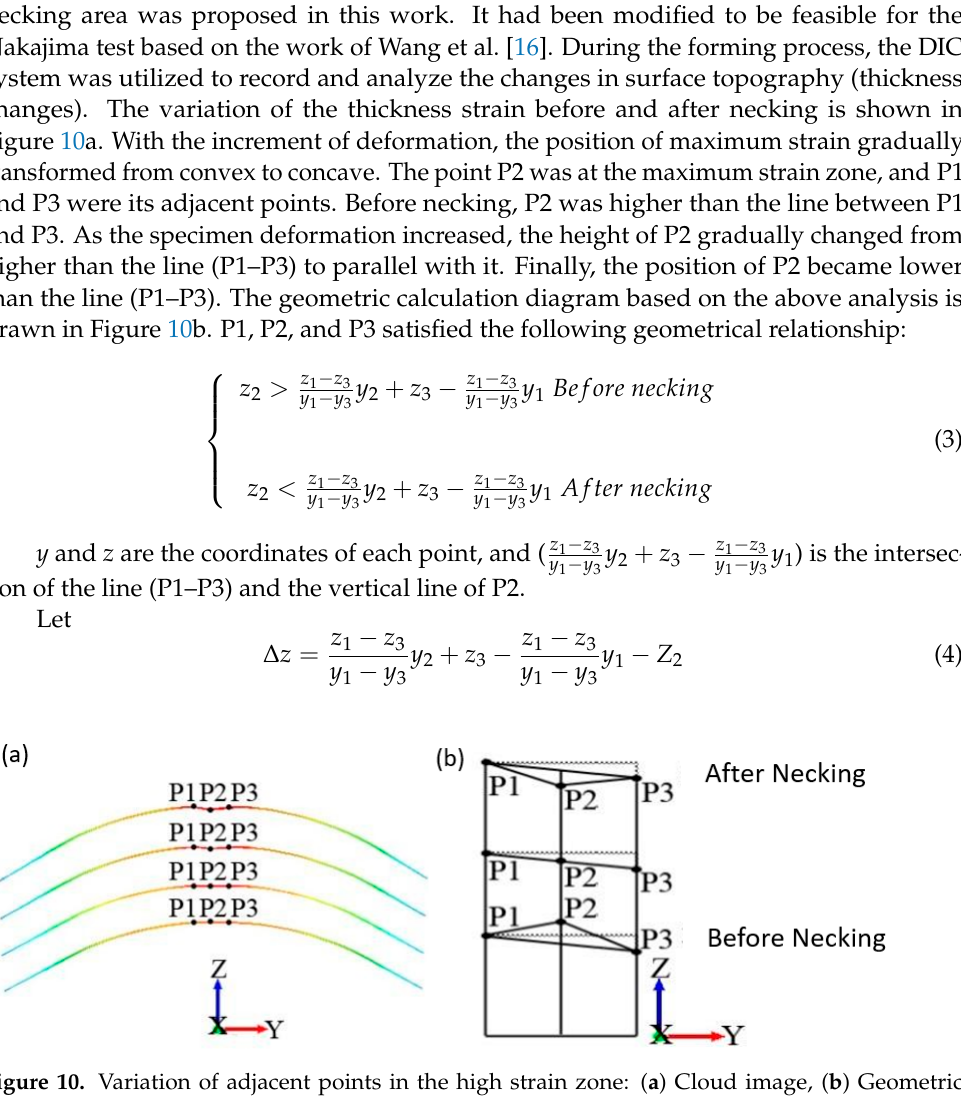
Figure 11. Variation tendency of Δz and necking time: ( a ) Uniaxial stretching strain region, ( b ) Biaxial stretching strain region.